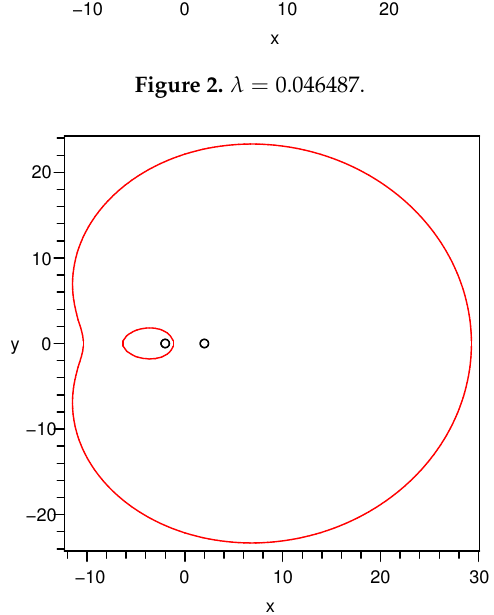
Figure 2. λ = 0.046487.